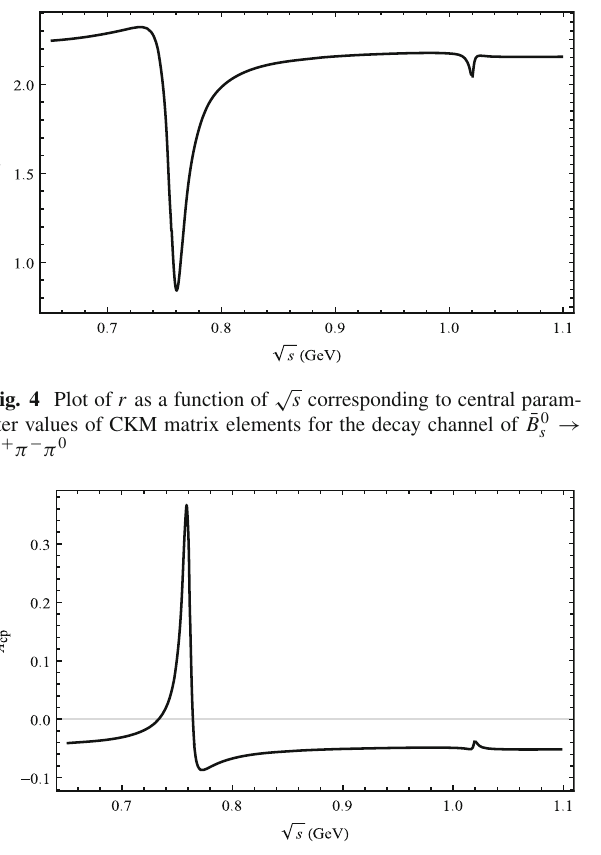
√ s corresponding to central